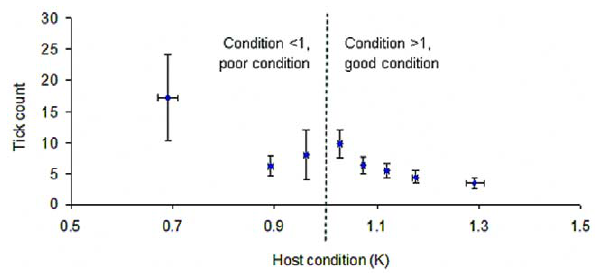
Figure 5. Biotic impact on tick count. Relationship of tick intensity to host condition (K). Standard error bars